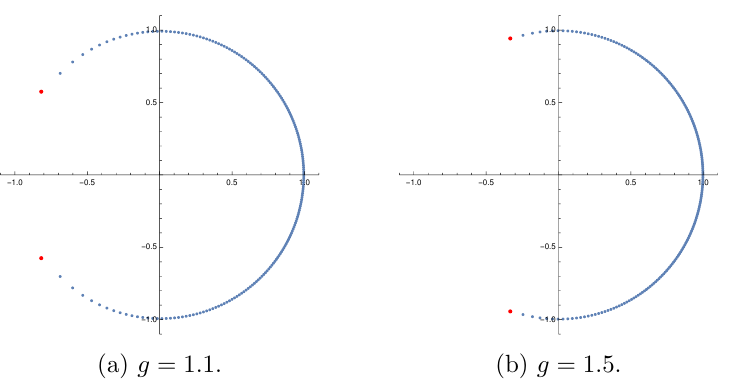
Figure 6. Plot of the eigenvalues of the matrix M (cid:0) 1 g = 1 : 5. The red dots represent the end-point e (cid:6) i (cid:11) of the cut in the large N limit.